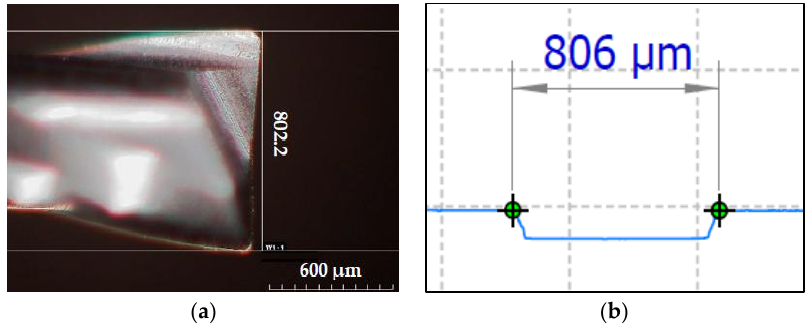
Figure 11. ( a ) Tool diameter measuring (Hirox RH-2000); ( b ) microchannel profile (Mitaka PF-60).